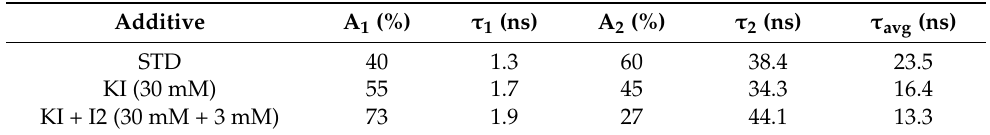
Table 4. List of the fast decay lifetime ( τ 1 ), slow decay lifetime ( τ 2 ), and PL average decay ( τ avg ) of the TiO 2 /FTO glass with various perovskite films.